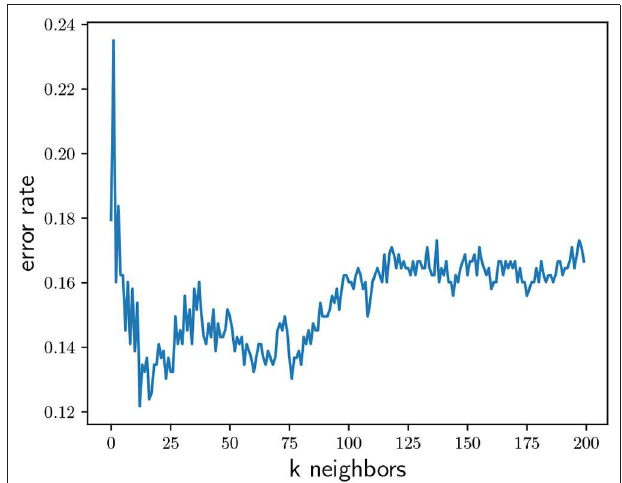
FIGURE 3 | Error rate as a function of K neighbors for the KNN classifier.